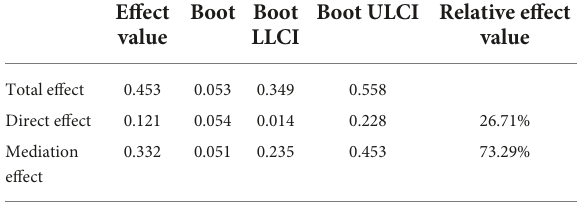
TABLE 9 Moderating effect regression